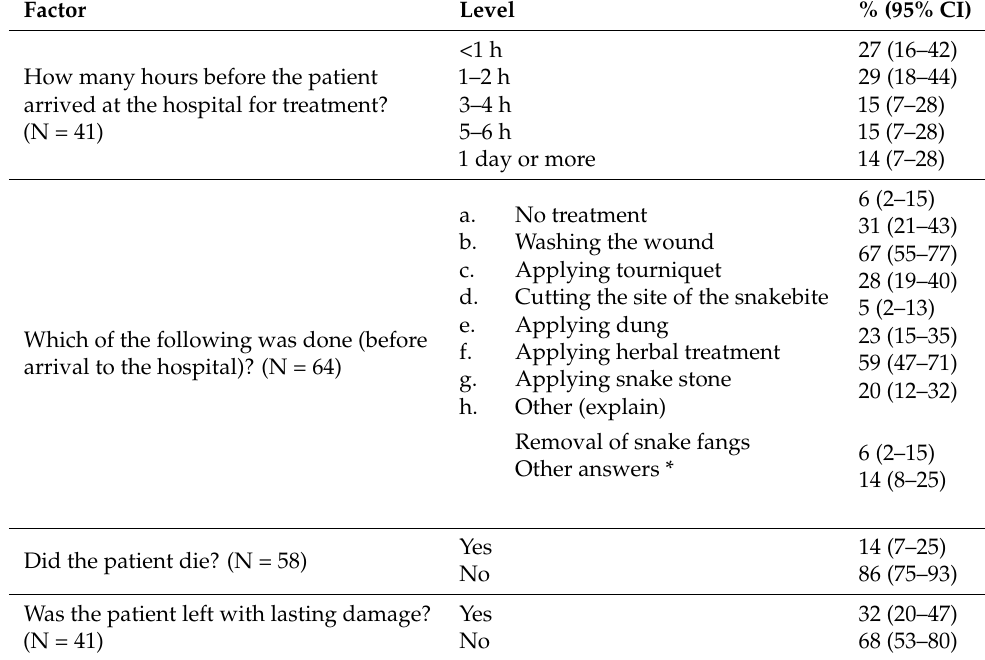
Table 4. Characteristics of snakebite victims upon arrival at the hospital and hospital outcomes (N =